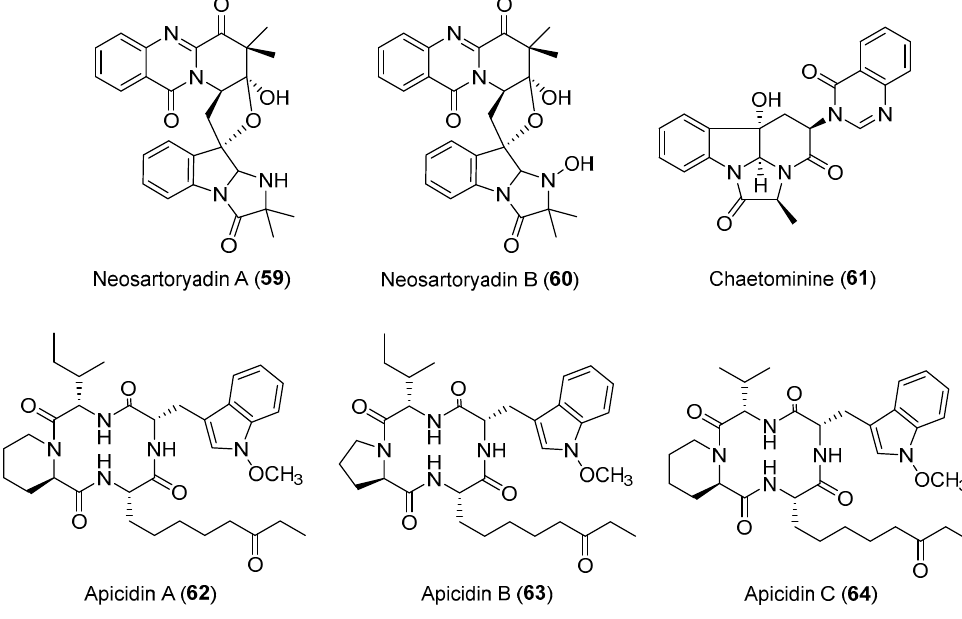
Figure 11. Structures of compounds 59 – 64 .